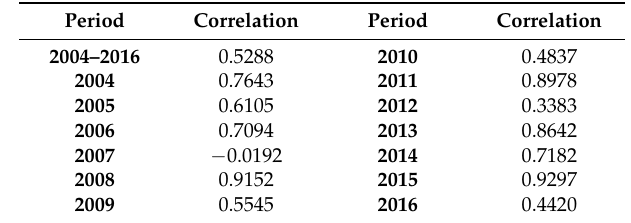
Table 8. Correlation between growth rate based indexes.